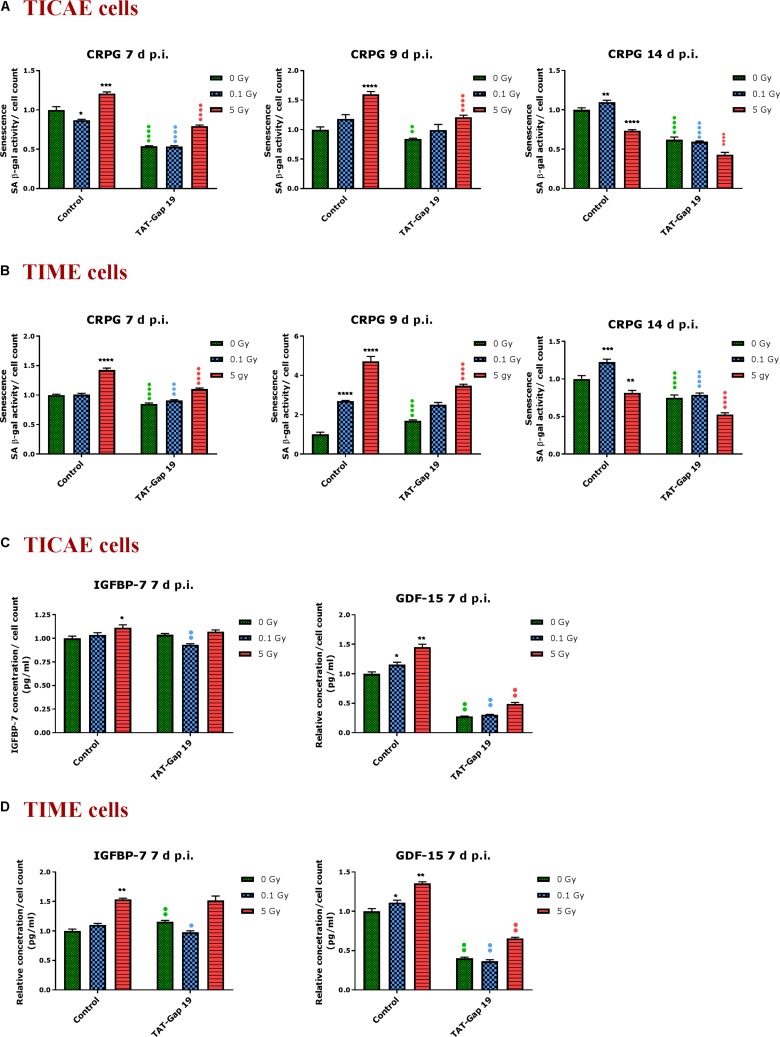
Radiation-induced premature endothelial senescence and effect of TAT-Gap19. Senescence-associated β-galactosidase activity was measured in a CPRG assay at 7, 9, and 14 days after radiation exposure (0.1 and 5 Gy) in (A) TICAE cells and (B) TIME cells. IGFBP-7 and GDF-15 were assessed in (C) TICAE cells and (D) TIME cells at 7 days p.i. The values represent the average ± SEM of 16–24 biological replicates in the CPRG assay and of six biological replicates in multiplex-based assays. Statistical significance was analyzed with a non-parametric Mann–Whitney T-test. *Indicates statistically significant differences compared to the respective 0 Gy controls. •Indicates statistically significant differences between the TAT-Gap19 group compared to the respective control condition (not treated with TAT-Gap19). */•p < 0.05; **/••p < 0.01., ***/•••P < 0.001, ****/••••P < 0.0001.